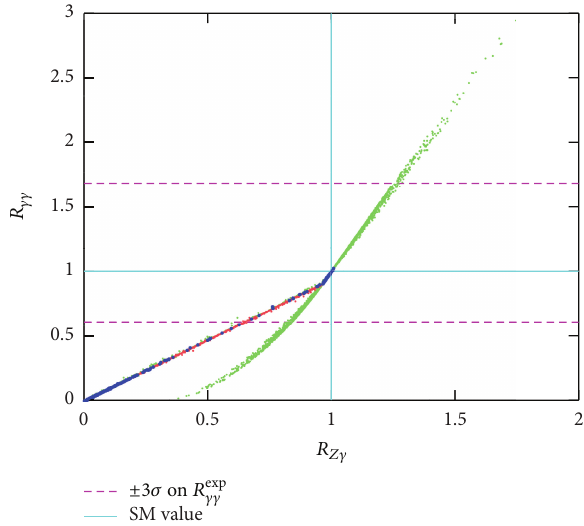
Figure 4: Relation between 𝑅 𝛾𝛾 and 𝑅 𝑍𝛾 for the same random scan of IHDM parameter